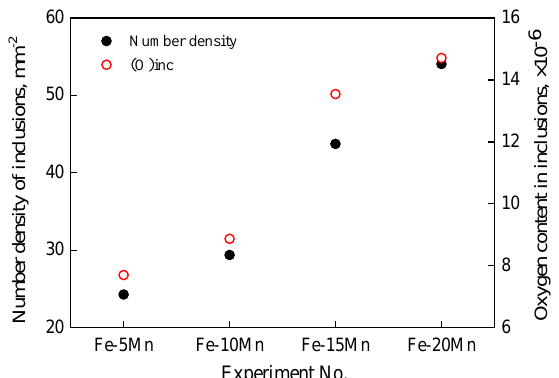
Figure 9. Number density and oxygen content of inclusions.